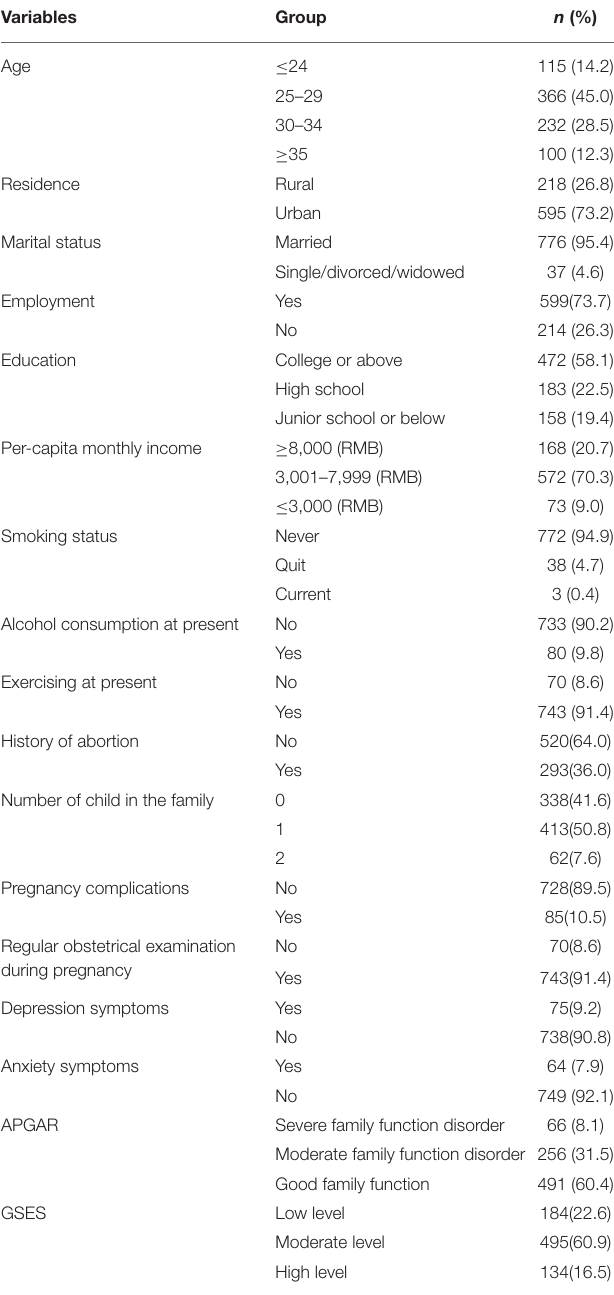
TABLE 1 | Demographic characteristic and anxiety and depression symptoms of pregnant women.